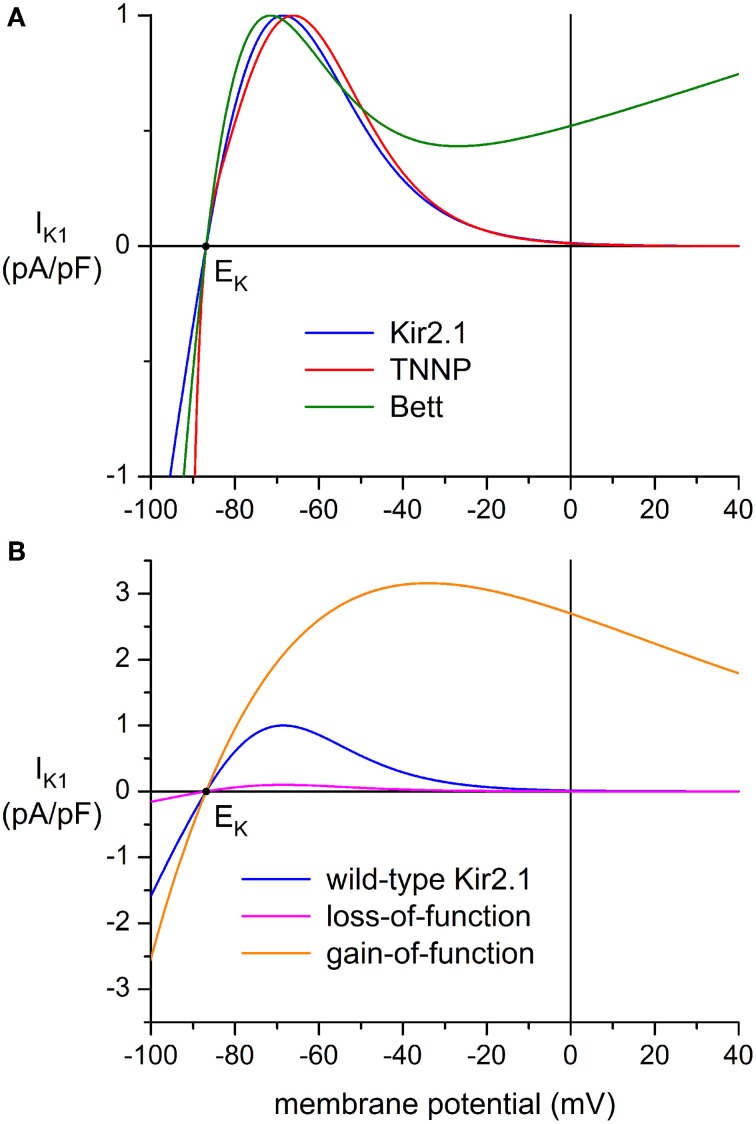
Current-voltage relationship of inward rectifier potassium current (IK1) added to human induced pluripotent stem cell derived cardiomyocytes (hiPSC-CMs) through dynamic clamp. (A) IK1 based on data from Kir2.1 channels expressed in HEK-293 cells by Dhamoon et al. (2004) (“Kir2.1,” blue line), IK1 from the human ventricular cell model by ten Tusscher et al. (2004) (“TNNP,” red line), and the synthetic IK1 used by Bett et al. (2013) (“Bett,” green line). Peak outward amplitude scaled to 1 pA/pF. (B) Current-voltage relationships for loss-of-function and gain-of-function mutations in Kir2.1, encoded by the KCNJ2 gene. The orange line (“gain-of-function”) represents the heterozygous E299V mutation in KCNJ2 studied by Deo et al. (2013), whereas the magenta line (“loss-of-function”) represents a dominant-negative mutation resulting in a decrease in amplitude to 10% of the wild-type Kir2.1 current of panel (A) (blue line). Note difference in ordinate scale between panels (A) and (B).